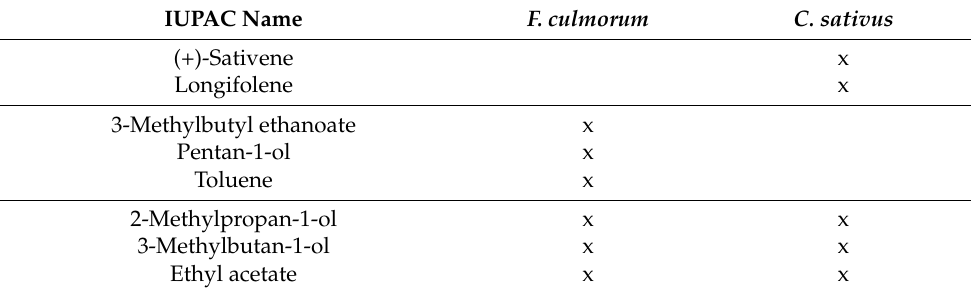
Table 1. List of individual VOCs and fungal species against which they were tested.